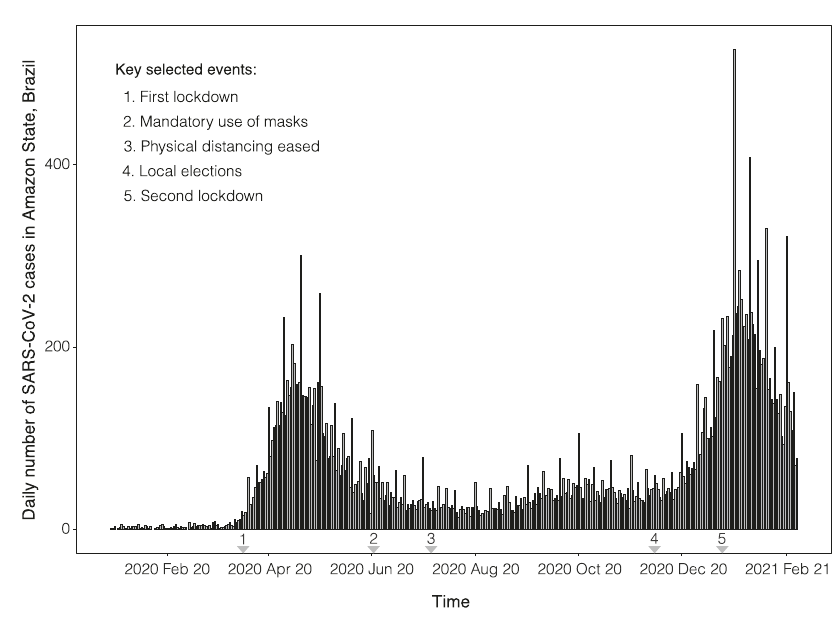
Fig. 2 | Con fi rmed incident SARS-CoV-2 cases from Amazonas state, north Brazil until 7th of February 2021. The arrows represent key policy change-times 52